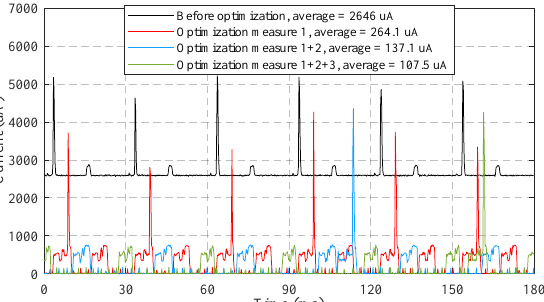
Figure 21. The measured currents of sensor under different optimization